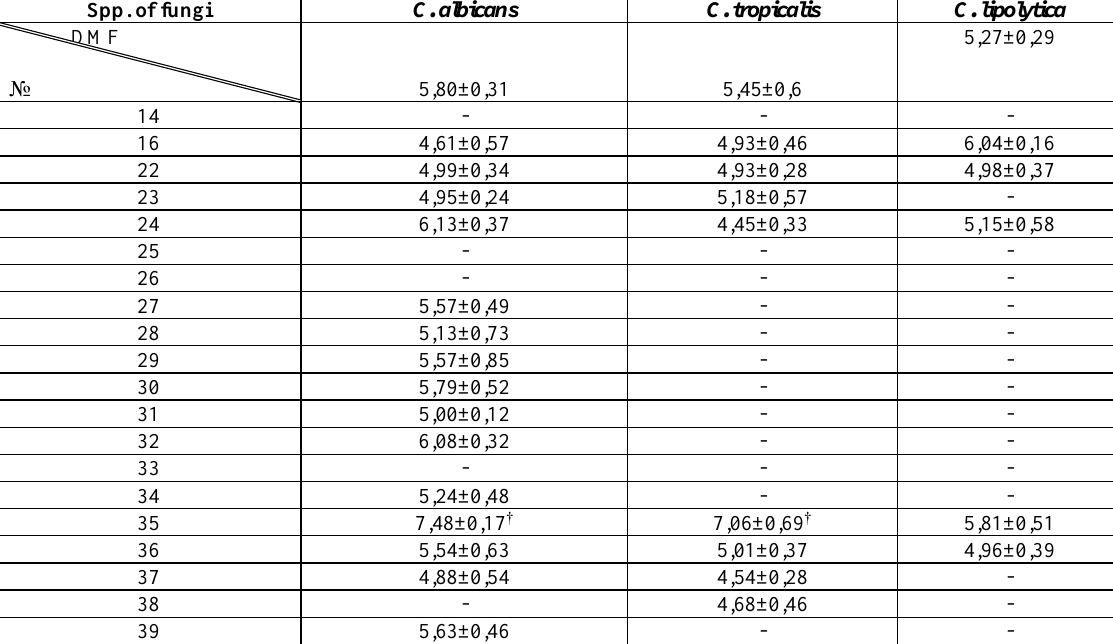
Table 4. Antimicrobial effect of synthesized compounds on fungi activity Spp. of